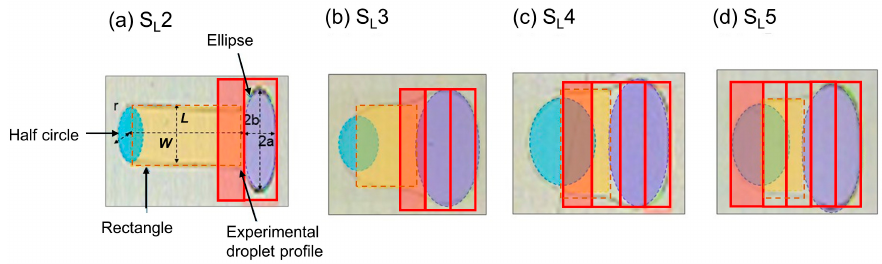
Figure 7. Approximate droplet shapes used for theoretical calculations of droplet motion on slender electrode arrays ( a – d ). For each sequence droplet footprint area consists of an elliptical front part (shaded in violet), rectangular middle part (shaded in light orange) and half circular back part (shaded in sky blue). Letters a and b denote the major and minor axis of the ellipse, L and W denote length and width of the rectangle, and r is the radius of the half circular part. The red outlines show the activated electrodes and the shaded portion shows the transition distance.